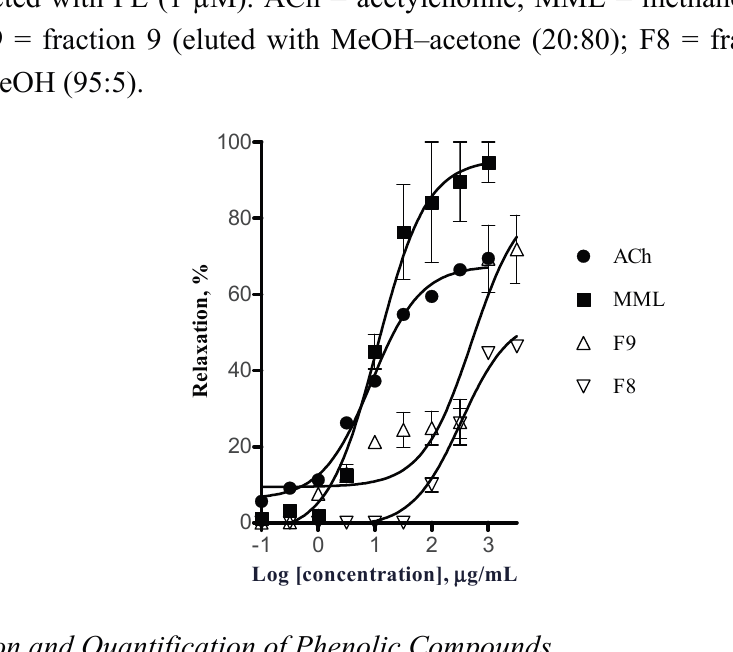
Figure 2. Vasorelaxant effects of fractions, MML extract and ACh on isolated rat aorta precontracted with PE (1 µM). ACh = acetylcholine; MML = methanol maceration of the leaves; F9 = fraction 9 (eluted with MeOH–acetone (20:80); F8 = fraction 8 eluted with